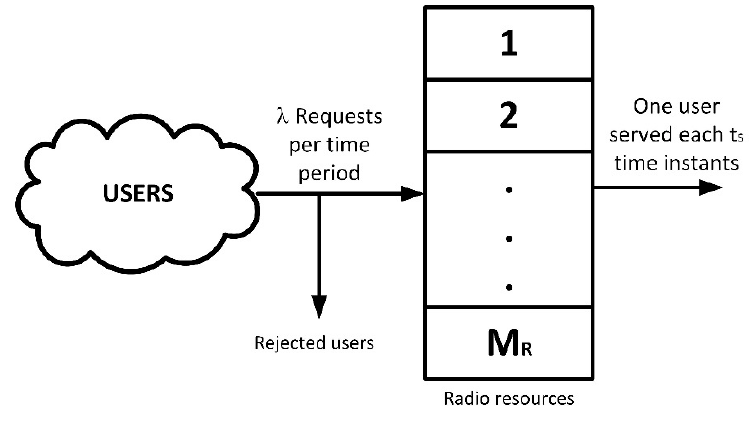
ffi c model for emergency services at radio Figure 3. BER evolution considering different SINR ratios and p values. Figure 3. Teletra